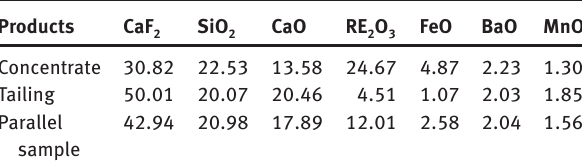
Table 5: Recovery ratio of RE in the products by centrifugal separation compared with the parallel sample Products